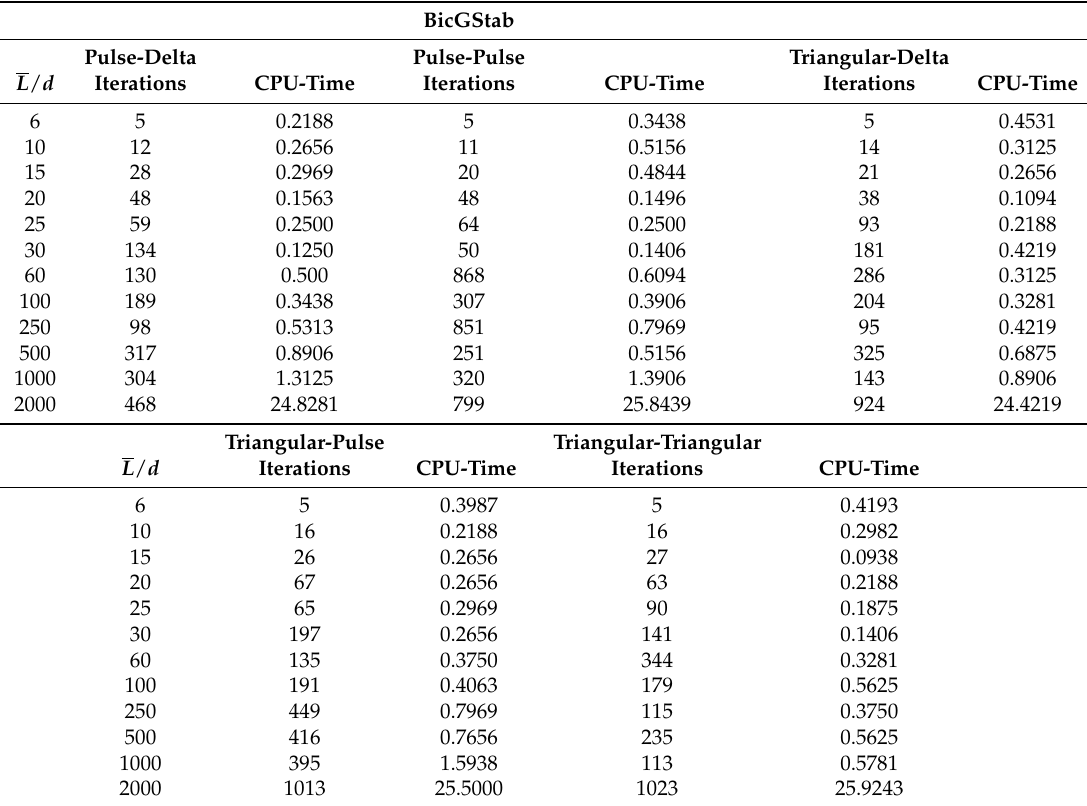
Table 9. BicGStab: CPU-time (s) and number of iterations for each pair basis-testing functions as